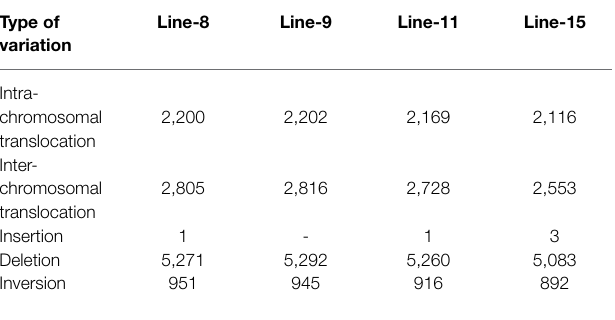
TABLE 5 | Structural variations in genomes of mutant line as compared to JBT